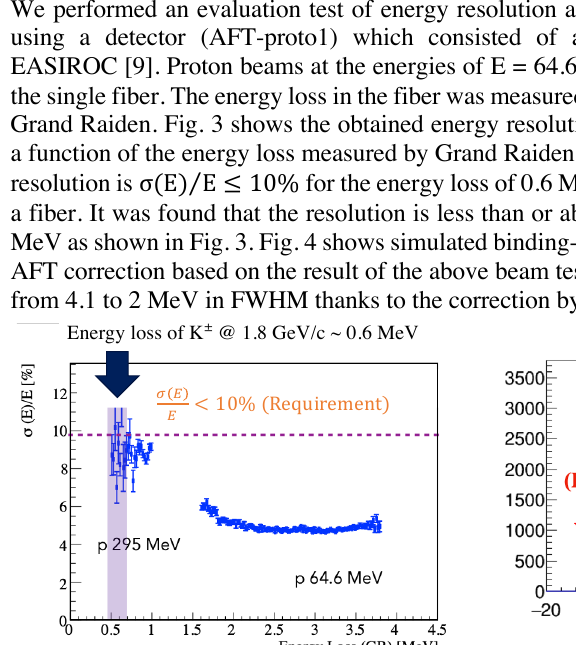
Fig. 4. Simulated spectra for the Ξ -binding energy for the 12 C (𝐾 ! , 𝐾 " ) Be #$% reaction. The energy resolution is improved to 2 MeV from 4.1 MeV (FWHM) by the correction using AFT.